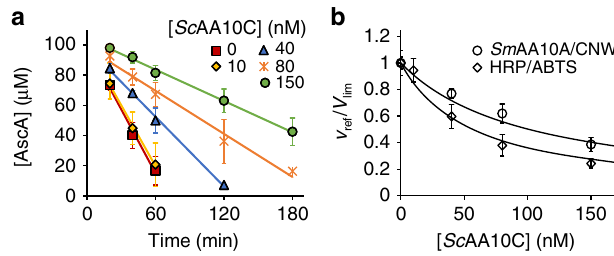
Fig. 6 Inhibition of HRP/ABTS and Sm AA10A/CNW by Sc AA10C /Avicel. All experiments were made in Bis-Tris buffer (50 mM, pH 6.1) at 25 °C and contained, AscA (0.1 mM), Avicel (100 g L − 1 ) and glucose (10 mM). a Progress curves for the oxidation of ABTS (0.2 mM) by HRP (1.0 nM) (measured as consumption of AscA) in the presence of Sc AA10C at different concentrations. Reactions were provided with GO (0.035 g L − 1 ). Solid lines show linear regression of the data. The slopes of the lines correspond to the rate of the reference reaction ( v ref ). b Dependency of v V Sc AA10C]. The data for the HRP/ABTS reference reaction are ref / lim on [ from panel ( a ). The data for the Sm AA10A/CNW reference reaction are from Supplementary Fig. 13. Solid lines show nonlinear regression of the data according to Eq. (5). Data are presented as average values ( n = 3, independent experiments) and error bars show SD. Source data are provided as a Source Data fi k cat / K of a cellulose-active family AA10 LPMO from the mH 2 O 2 bacterium S. coelicolor ( Sc AA10C), using Avicel (100 g L − 1 ) as substrate. GO with glucose was used as a source of H 2 O 2 and the was measured using two reference reactions, apparent k cat / K mH 2 O 2 HRP/ABTS (Fig. 6) and Sm AA10A/CNW (Supplementary values for Sc AA10C obtained Fig. 13). The apparent k cat / K mH 2 O 2 using two very different reference reactions were within error limits to each other (0.13 – 0.15 μ M − 1 s − 1 ; Table 1) and more